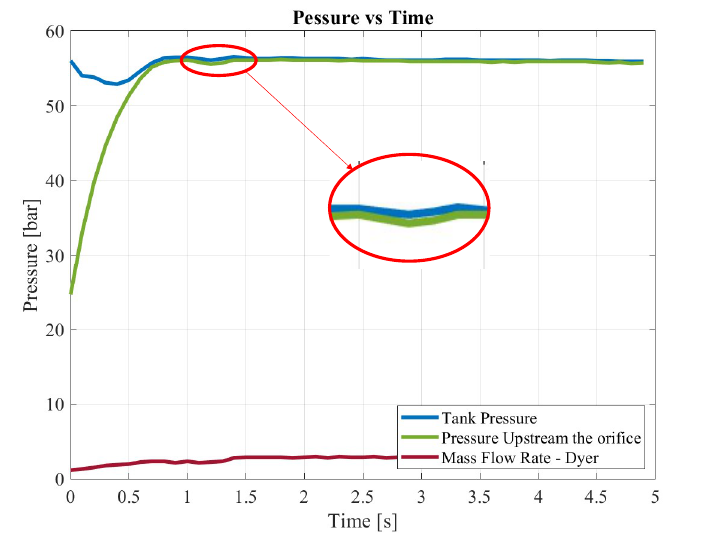
Figure 9. Test 7 experimental pressure trace, while highlighting the pressure rise that is possibly associated with the sudden peak in the mass flow